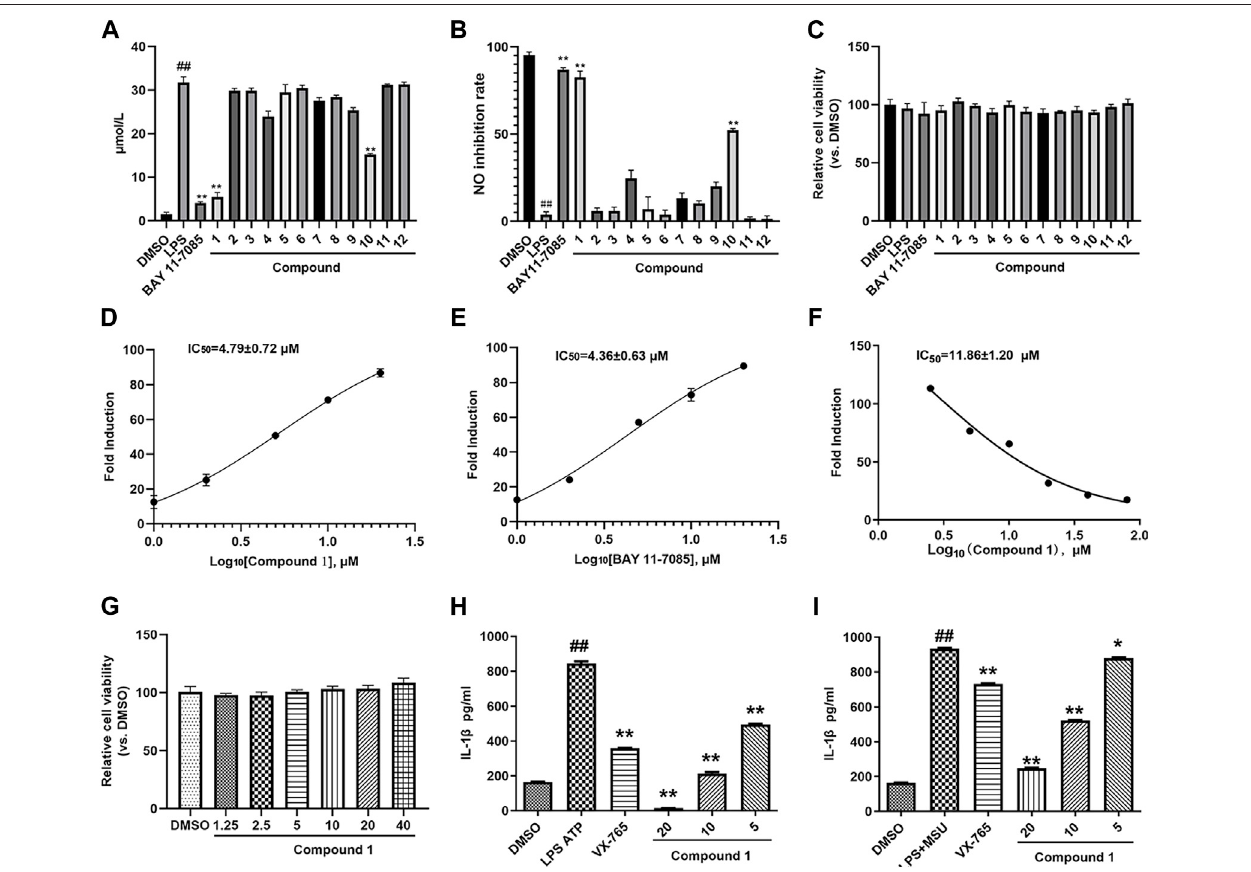
FIGURE 3 | Compound 1 inhibited IL-1 β release. (A) PMA-differentiated THP-1 cells were treated with compounds 1 – 12 (10 μ M) and BAY 11-7085 (10 μ M) and stimulated with LPS (0.5 μ g/ml) for 24 h, cell supernatants were collected for NO detection. (B) NO production inhibition rate. (C) The cytotoxicity of compounds 1 – 12 (10 μ M)andBAY11-7085(10 μ M)inTHP-1cells. (D,E) TheIC 50 valueofcompound 1(D) andBAY11-7085 (E) onNOproduction. (F) TheIC 50 valueofcompound 1 on IL-1 β release. (G) The cytotoxicity of different doses of compounds 1 in THP-1 cells. (H,I) LPS (1 μ g/ml) priming PMA-differentiated THP-1 cells were treated with various doses of compound 1 and VX-765 (500 nM) and stimulated with MSU (150 mg/ml) or ATP (5 mM), cell supernatants were collected for IL-1 β production. Cont., DMSO control. ## p < 0.01 compared with the control group, * p < 0.05, ** p < 0.01 compared with the model group.